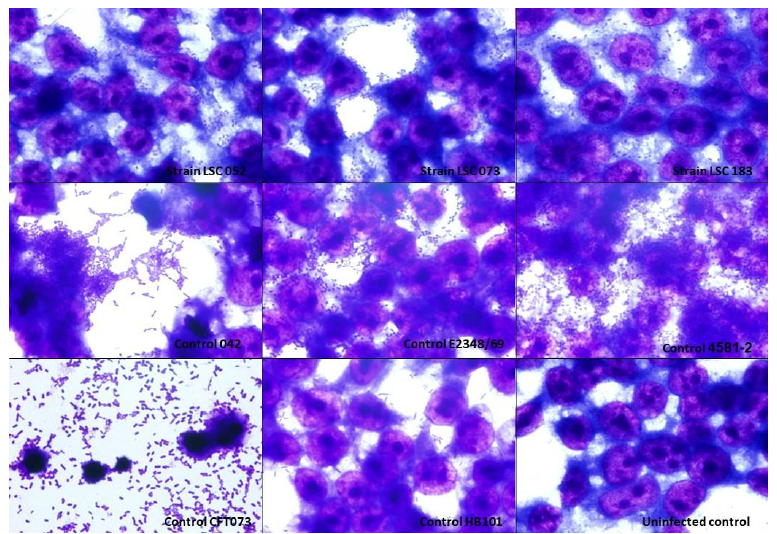
Figure 2. Interaction of hybrid uropathogenic Escherichia coli (UPEC) strains with HEK 293T cells of renal origin. The ability of hybrid UPEC strains to interact with human kidney cells was evaluated in assays with an incubation period of 3 h, at 37 °C without D-mannose, using a multiplicity of infection of 10. The preparations were stained with May-Grünwald/Giemsa and observed under an optical microscope (magnification ×1000). All hybrid UPEC strains interacted with the kidney cells in different strengths. E. coli strains used as controls: 042 (prototype EAEC); E2348/69 (prototype typical EPEC); 4581-2 (atypical EPEC); CFT073 (prototype UPEC); HB101 strain (non-adherent E. coli K-12-derived laboratory strain).